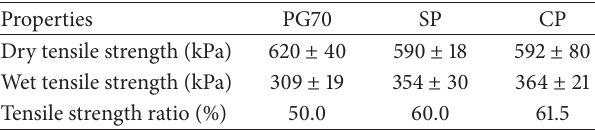
Table 3: Results of IDT